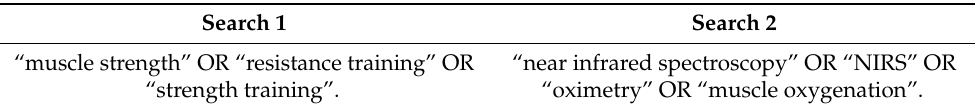
Table 1. Search terms and keywords utilized in each database search. Searches 1 and 2 were combined using ‘AND’. Search 1 Search 2 “muscle strength” OR “resistance training” OR “near infrared spectroscopy” OR “NIRS” OR “strength training”. “oximetry” OR “muscle